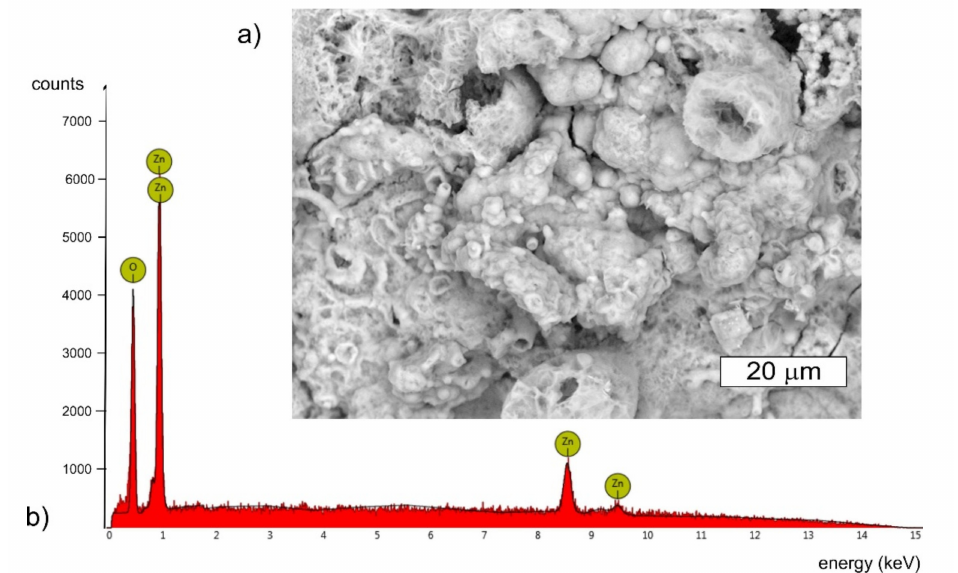
Figure 5. The deposit observed under the S1 bolt head: ( a ) SEM image, BSD ( b ) Characteristic X-ray spectrum for the presented area, SEM/EDX.3.2.2. Bolt 2.